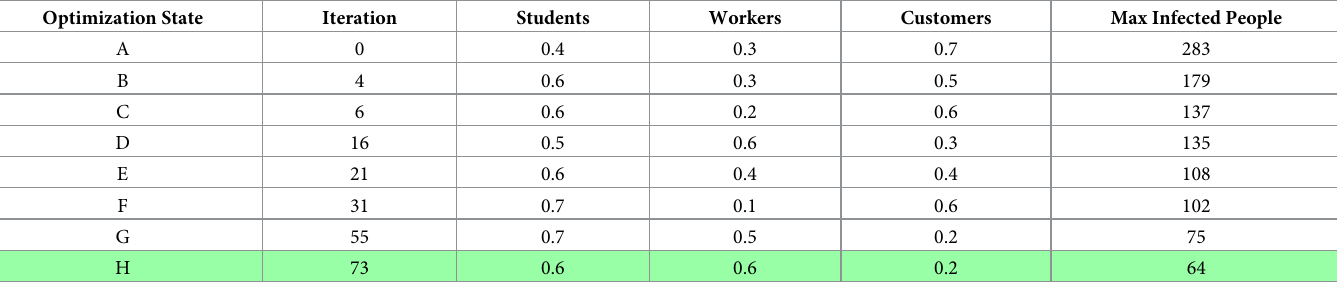
Table 8. A summary of the discovered control strategies during the rounds of the optimization process. The first column is the index of the discovered quarantine strategy. Each strategy consists of three ratios that show the portion of each group of {students, workers, customers} to put in quarantine. The second column indicates the iteration at which the associated strategy is found, and the rightmost column shows the value of the cost function for that strategy. This table only incorporates the itera- tions at which the agent improves the strategy. It can be seen that, at earlier rounds, the agent picks a large ratio of students, and only in later rounds, it realizes the critical effect of quarantining workers. Each iteration equals a single run with a population size of 2k, and takes (13.8 ± 5.7) minutes with average computational power. Optimization State Iteration Students Workers Customers Max Infected